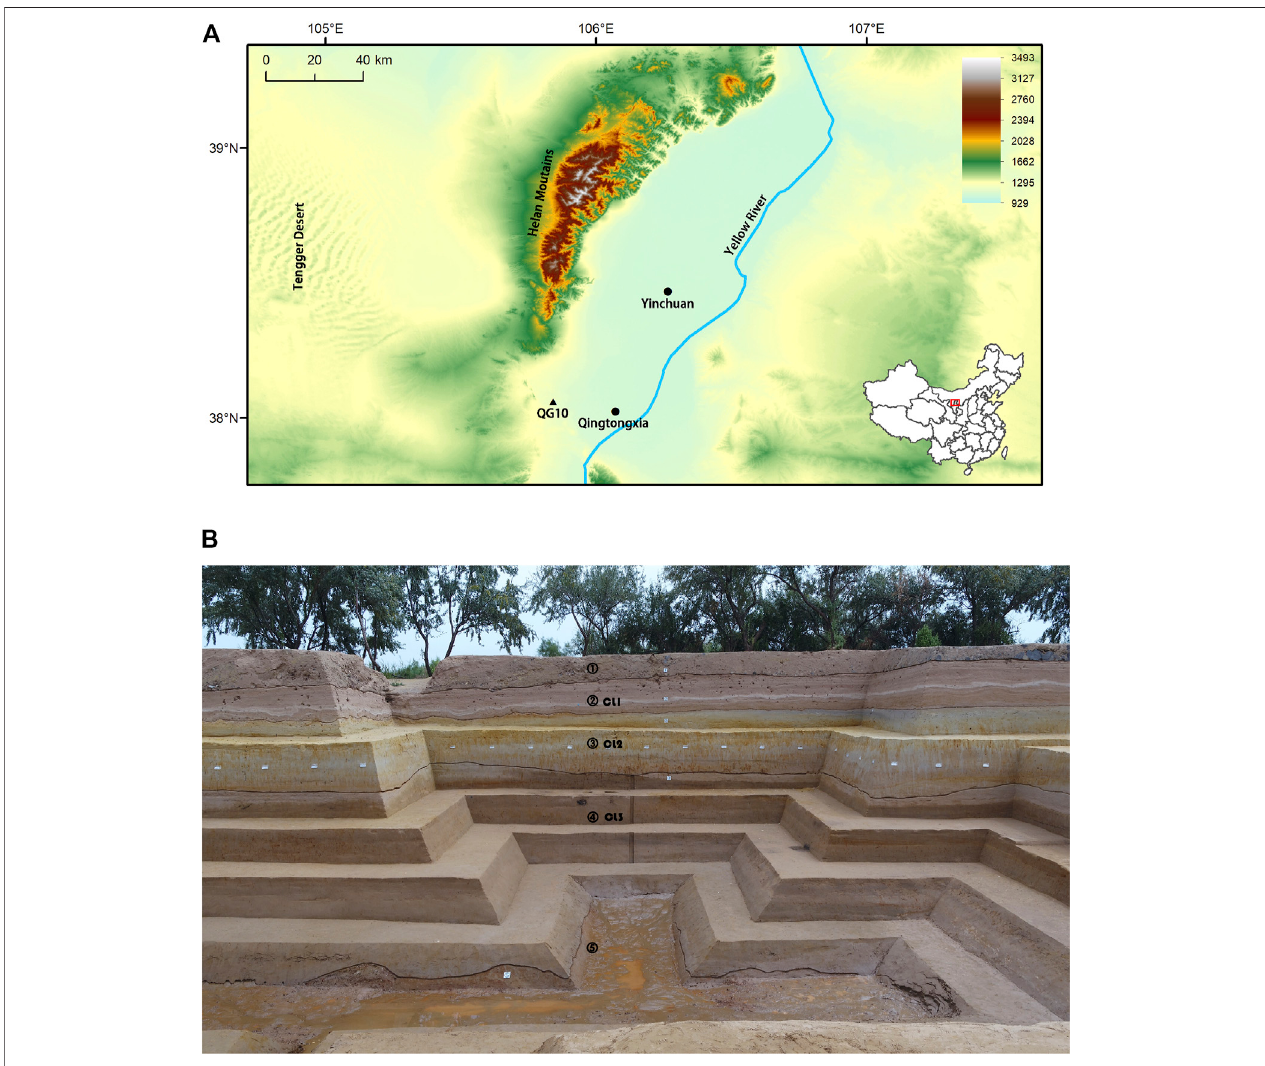
FIGURE 1 | (A) Location of QG10 (Qingtongxia City, Ningxia Hui Autonomous Region of China; (B) Stratigraphy indicating the geological layers (1 – 5) and archaeological horizons (CL1-CL3) (after Guan et al., 2020).